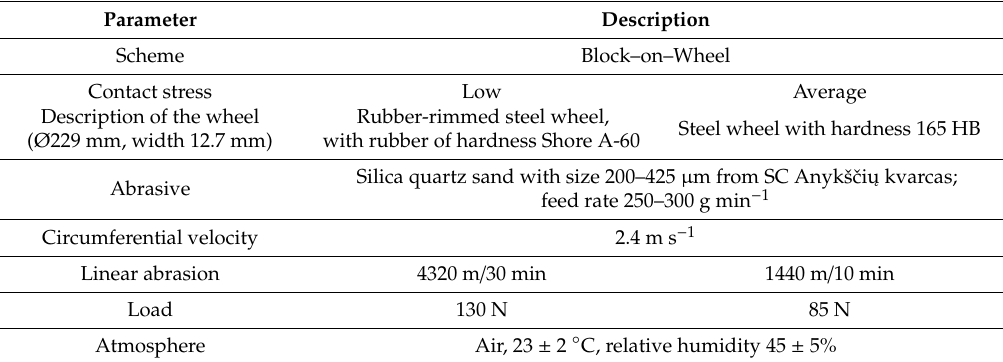
Figure 4. Schematic of the devices used for testing samples under abrasive conditions: ( a ) according to ASTM G65 (1—rubber-rimmed steel wheel; 2—abrasive supply nozzle; 3—sample; 4—load; 5—quartz sand); ( b ) according to GOST 23.201-78 (1—samples; 2—erodent hopper; 3—rotor with channels; 4—electrical motor [25]. Table 3. Three-body abrasive wear test conditions.